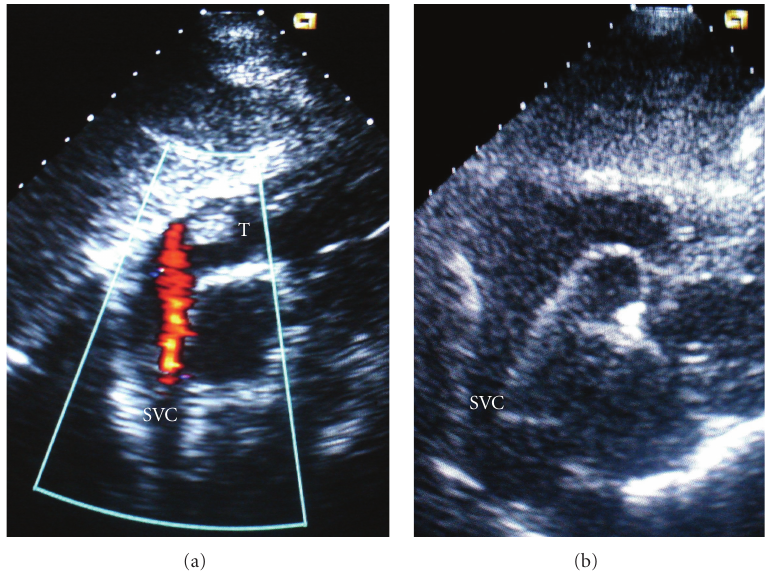
Figure 2: (a) Subcostal short axis projection. Thrombus in the SVC. Incomplete obstruction as shown by the flow approaching the probe. (b) Same view after oral anticoagulation therapy. SVC: superior vena